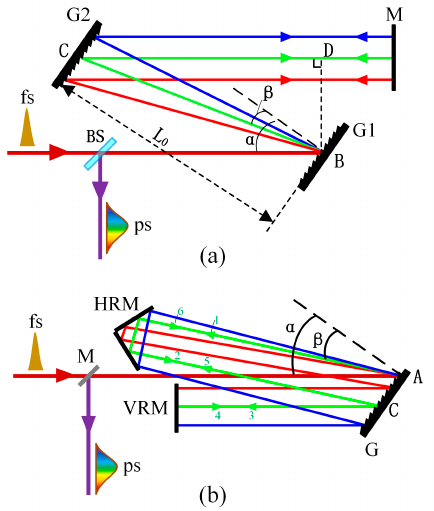
Figure 1. ( a ) The typical structure of a parallel grating pair chirped pulse stretcher, ( b ) the optical structure of our home-made stretcher with a single grating. BS, beam splitter; G, grating; M, mirror; a , incident angle; β , diffraction angle; L 0 , the vertical distance between the grating pair, HRM, horizontal roof mirror; VRM, vertical roof mirror. The arrows and numbers in ( b ) denote the light propagation order.